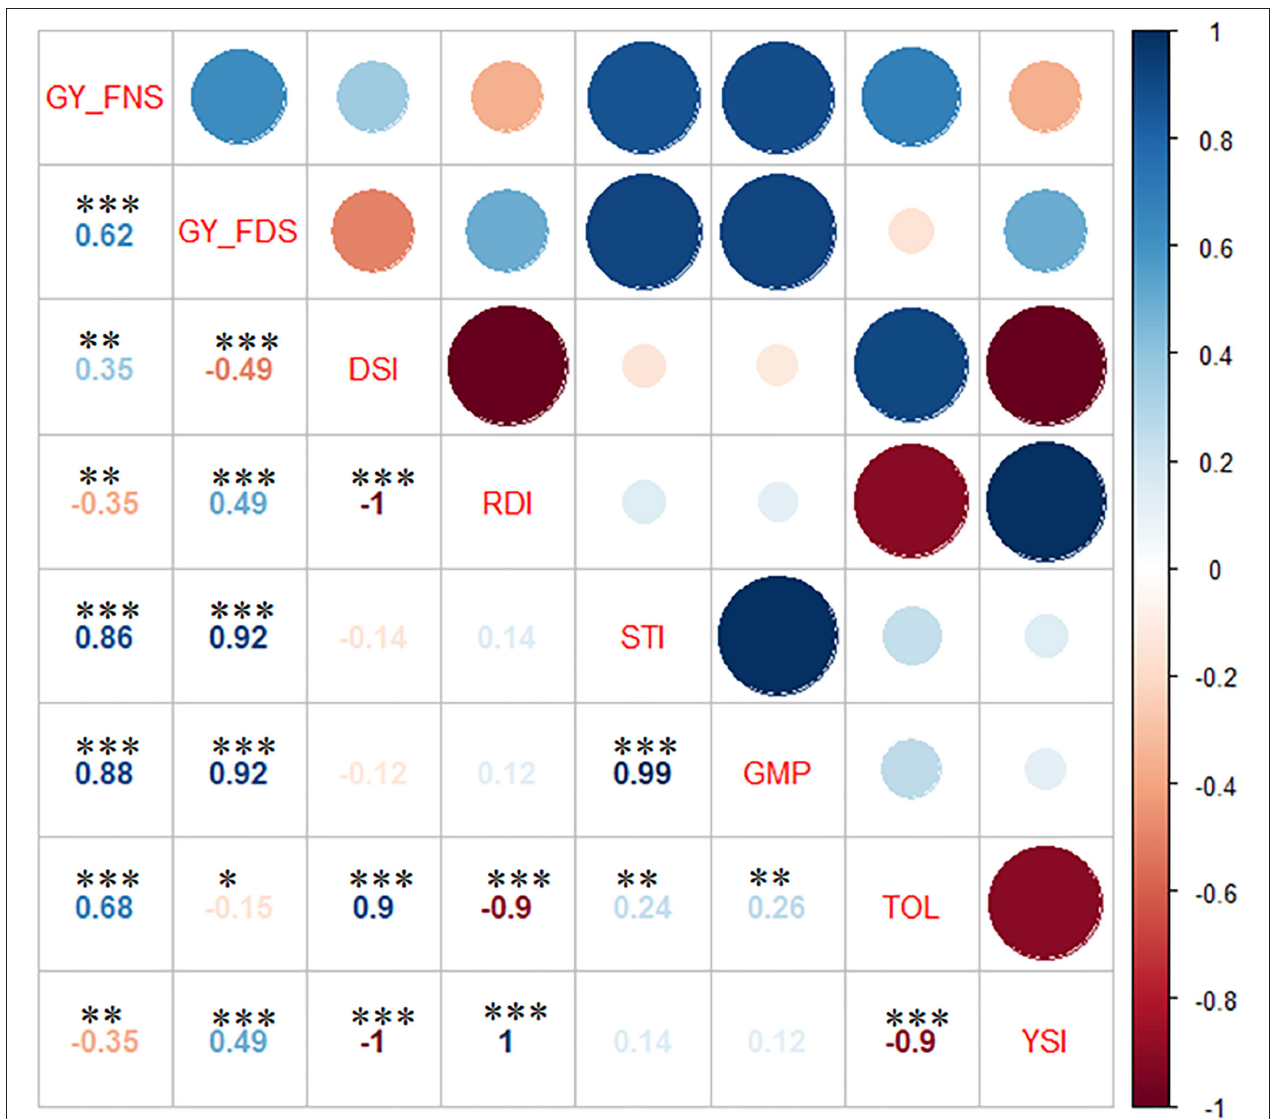
FIGURE 2 | Pearson correlation between the drought indices traits. GY_FNS, lsmeans from FNS at Holeta and Debre Zeit; GY_FDS, lsmeans from FDS at Dera and Melkassa; DSI, Drought susceptibility index; RDI, relative drought index; STI, stress tolerance index; GMP, geometric mean productivity; TOL, tolerance index; YSI, yield stability index. * , ** , and *** significance at p < 0.05, p < 0.01, and p < 0.001, respectively.